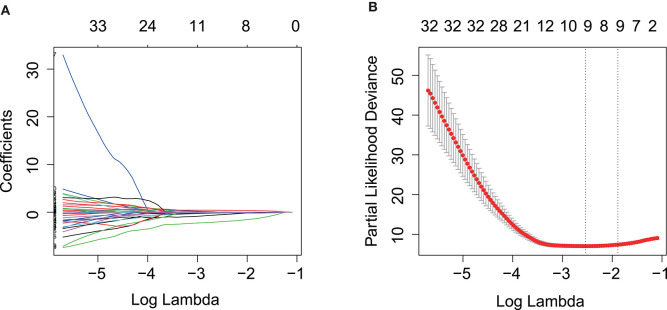
Prognostic gene signature was established by LASSO regression analysis. (A) LASSO coefficient profiles of the 110 genes in training cohort. (B) A coefficient profile plot was generated against the log (lambda) sequence. Selection of the optimal parameter (lambda) in the LASSO model for training cohort. LASSO, the least absolute shrinkage and selection operator Cox regression model.